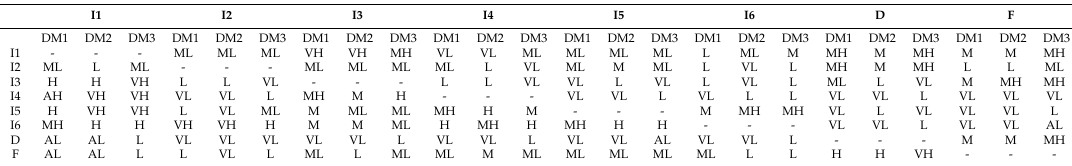
Table A7. Linguistic evaluations of